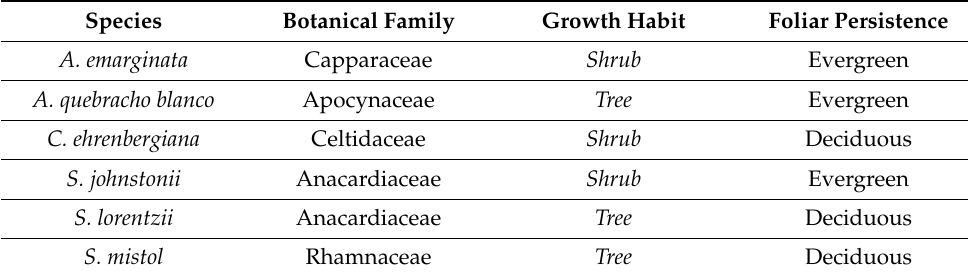
Table 1. Botanical family, foliar persistence, and growth habit for the studied species.